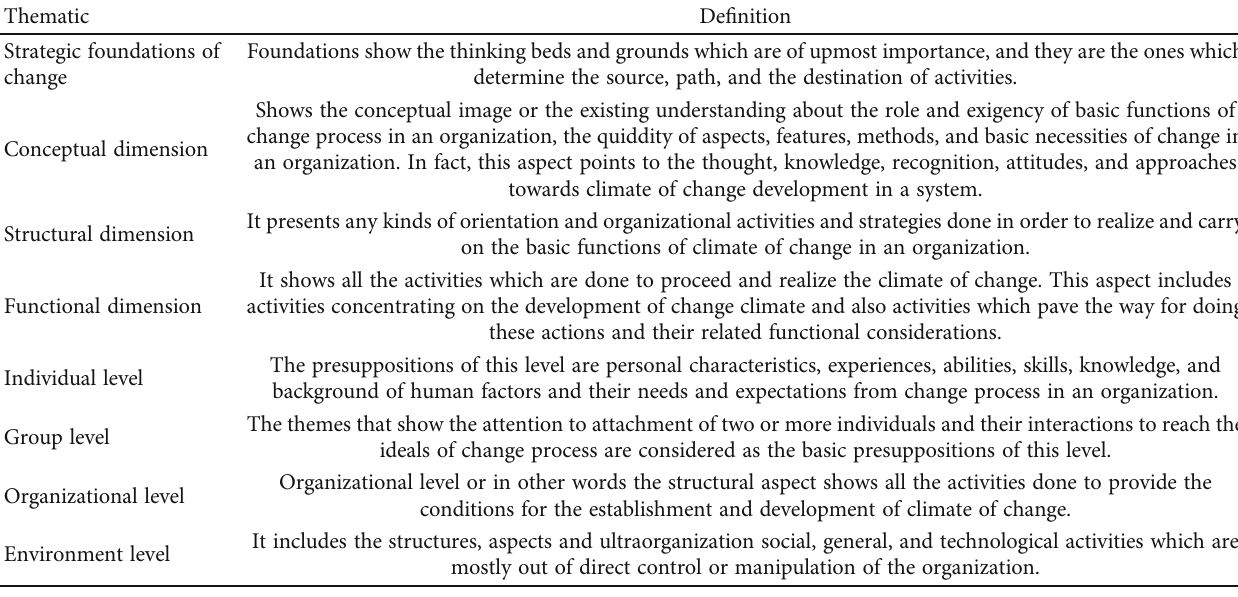
Table 1: Change climate organizing